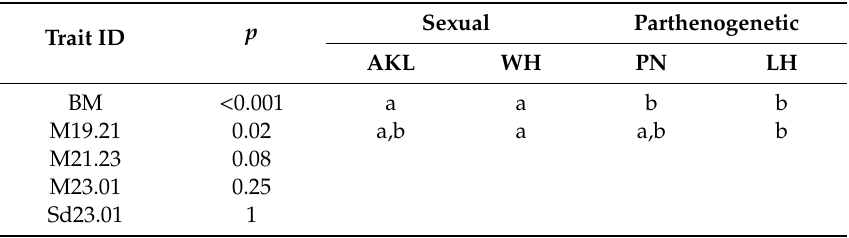
Table 3. Sexual and parthenogenetic female Clitarchus hookeri stick insects from four populations di ff er in body size but have similar chemical volatile emissions, as resolved by a Friedman test and pairwise Mann–Whitney comparisons (Sexual: AKL = Auckland, WH = Whanganui; Parthenogenetic: PN = PalmerstonNorth, LH = LowerHutt).